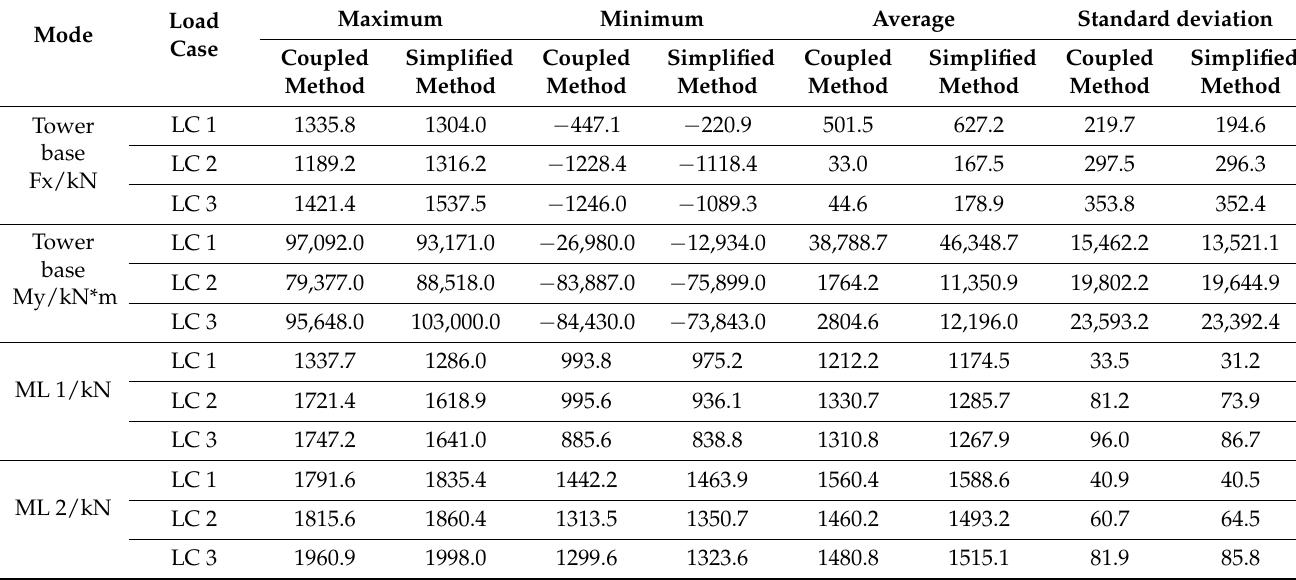
Figure 12. Mooring line force of WindFloat SFOWT under different load cases: ( a ) ML 1; ( b ) ML 2. Table 7. Statistical results of tower base loads and mooring line tension.